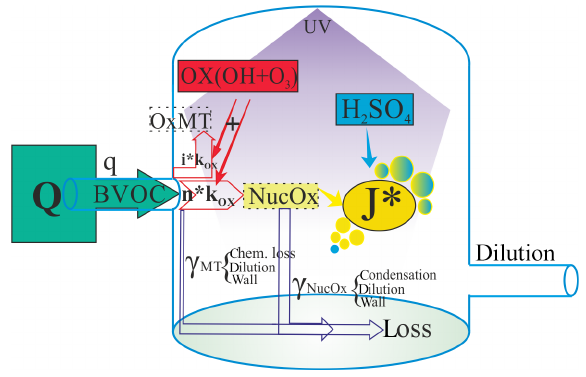
Figure 7. A conceptual figure of the gas-phase reaction system lead- ing to the formation of nanoCN in the JPAC chamber. BVOC are emitted in the plant chamber ( Q ) and then transported to the reac- tion chamber in the connecting flow, leading to a source rate q in the reaction volume. BVOC then reacts, producing oxidized prod- ucts that are either able to participate in nanoCN formation (NucOx) or inert products (OxVOC), with fractional yields n and i , respec- tively. BVOC can also be lost by other pathways. NucOx has two fates: react with H 2 SO 4 or be lost by condensation (to particles or the wall) or dilution. The loss process is dominant. The reaction with H 2 SO 4 produces